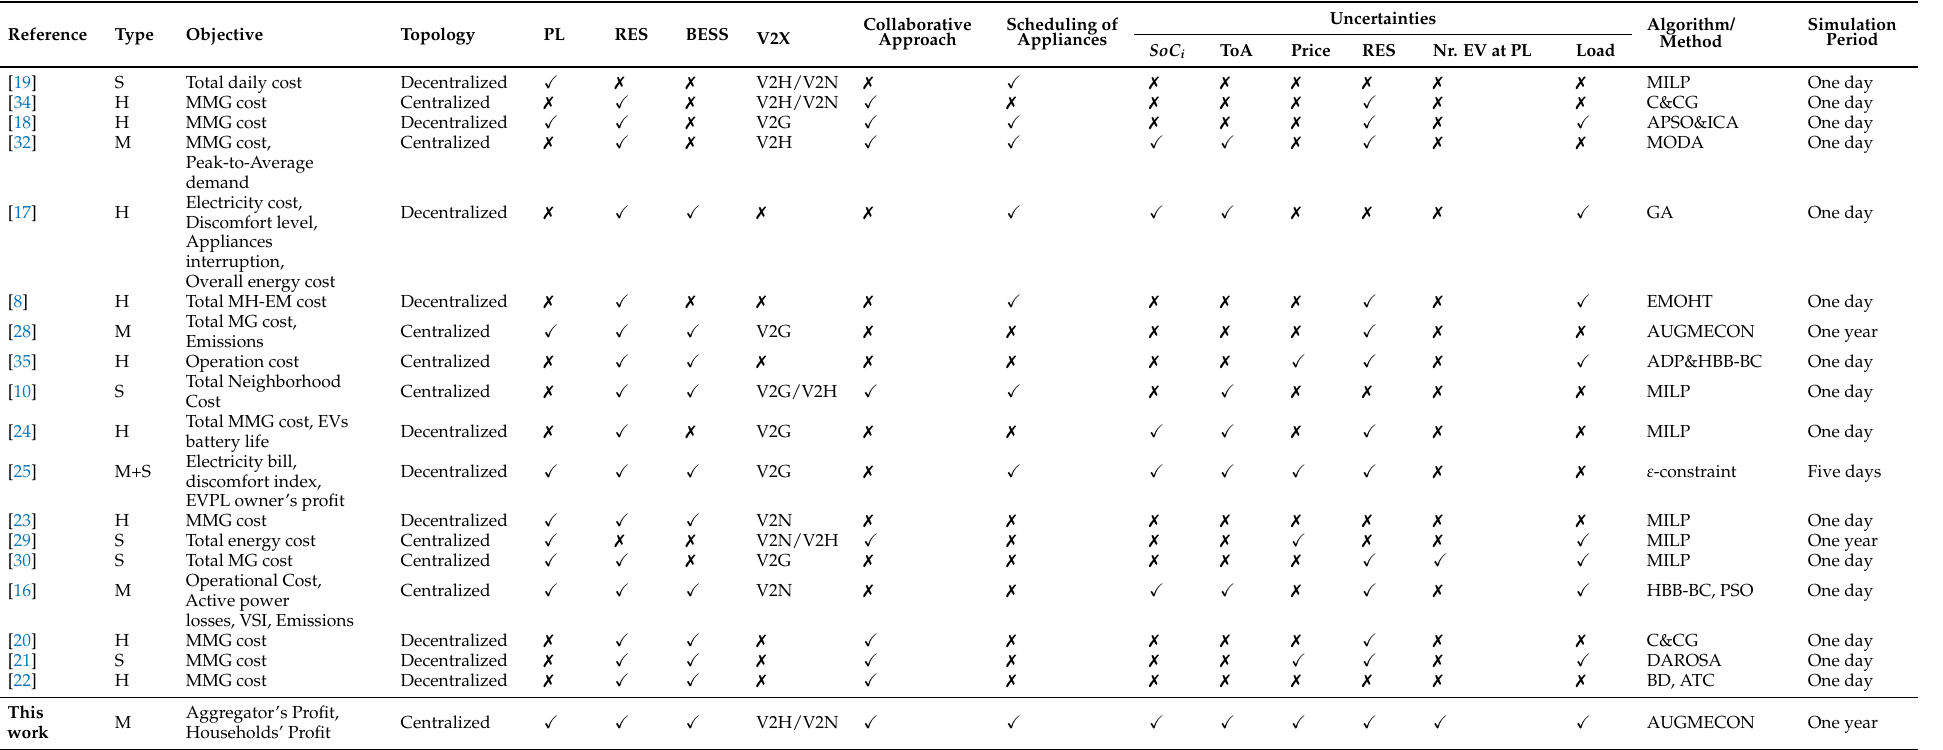
Table 1. Comparison with previous studies. S, M, and H stand, respectively, for single-objective, multi-objective, and hierarchical. EVPL indicates an electric vehicle parking Lot. MG stands for microgrid, while MMG denotes a